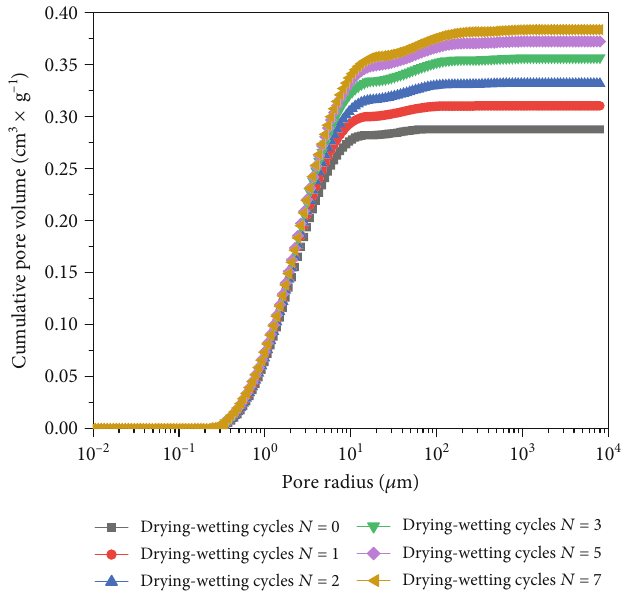
Figure 10: Relationships between cumulative pore volume and pore radius. Table 5: Pore-size distribution fi tting parameters of drying – wetting cycle samples.